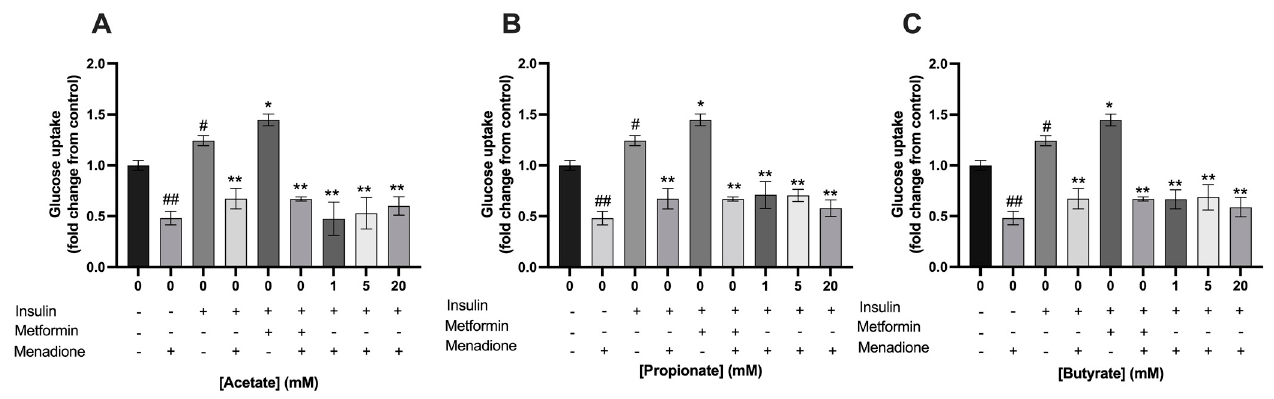
Figure 8. Exposure to single SCFAs did not prevent menadione induced reduction in glucose uptake in C2C12 myotubes . Exposure to acetate ( A ), propionate ( B ), nor butyrate ( C ) prevented menadione ‐ induced reduction in glucose uptake in C2C12 myotubes (N ≥ 3, n = 2). All data are presented as mean ± SEM. # p < 0.01 compared to 0 mM SCFA, ## p < 0.001 compared to 0 mM SCFA, * p < 0.01 compared to 0 mM SCFA treated with 100 nM insulin; ** p < 0.001 compared to 0 mM SCFA treated with 100 nM insulin. Fold change was calculated from control without insulin treatment.